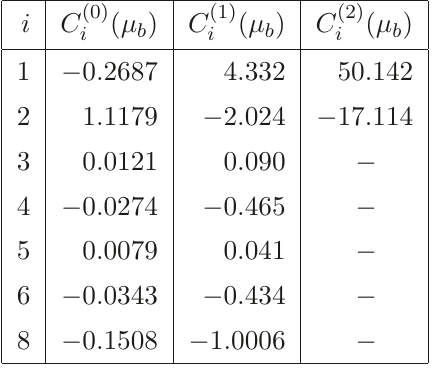
( µ b ) at µ b = ¯ m b = 4 . 18 GeV using i ( µ b ) and C ( k ) ( µ b ). The 1 2